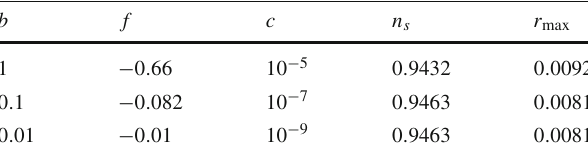
Table 2 Three sets of the parameter values used to produce the power spectrum peaks in Fig. 5. In all these cases we have (cid:17) N 2 ≈ 20 and M PBH ∼ 10 17